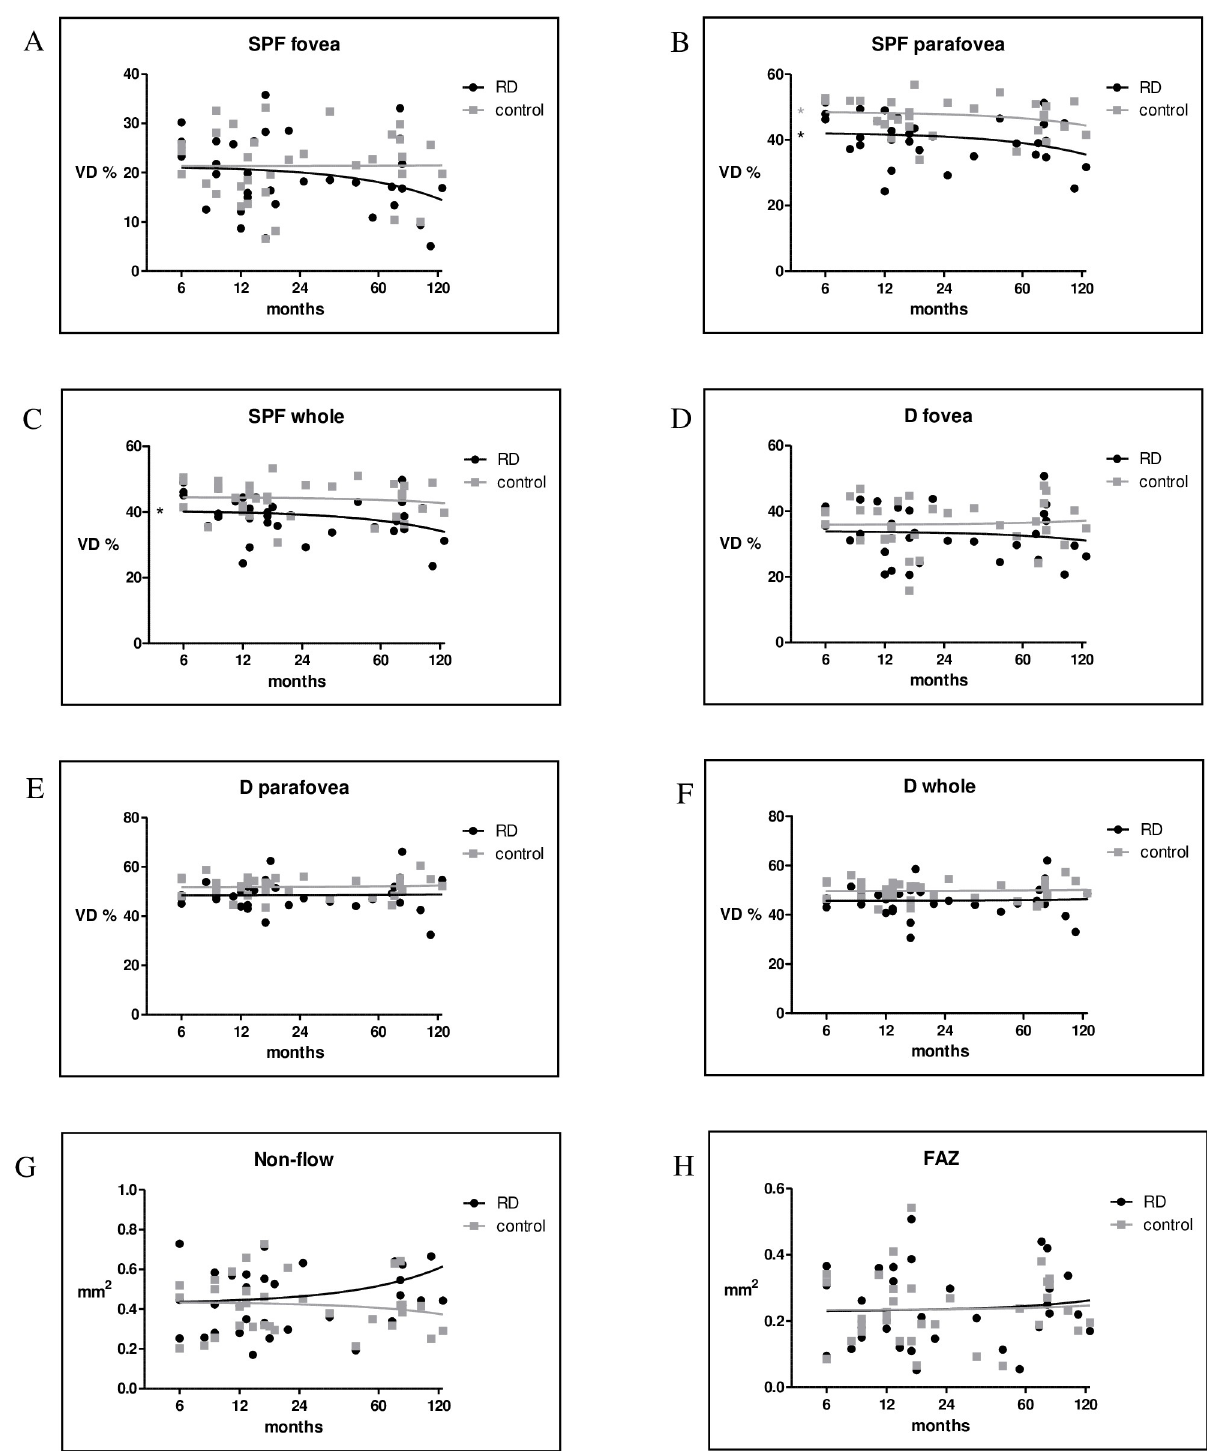
Fig 2. Correlation diagram between time and superficial (SPF, A-C), deep (D) retinal vascular density (D-F), non-flow area (G), and FAZ (foveal avascular zone, H). VD: vessel density. Statistically significant differences between the groups are marked by an asterisk. � p < 0.05.